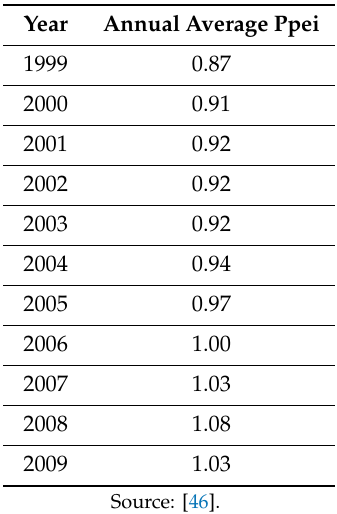
Table 4. Historical values of Industrial Price Index (Base